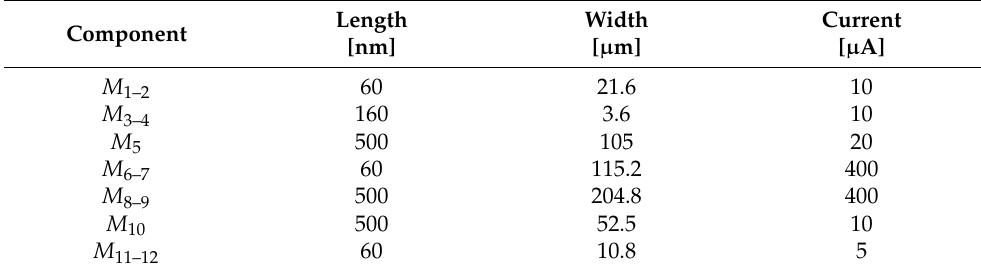
Table 2. Parameters of the OTA transistors.